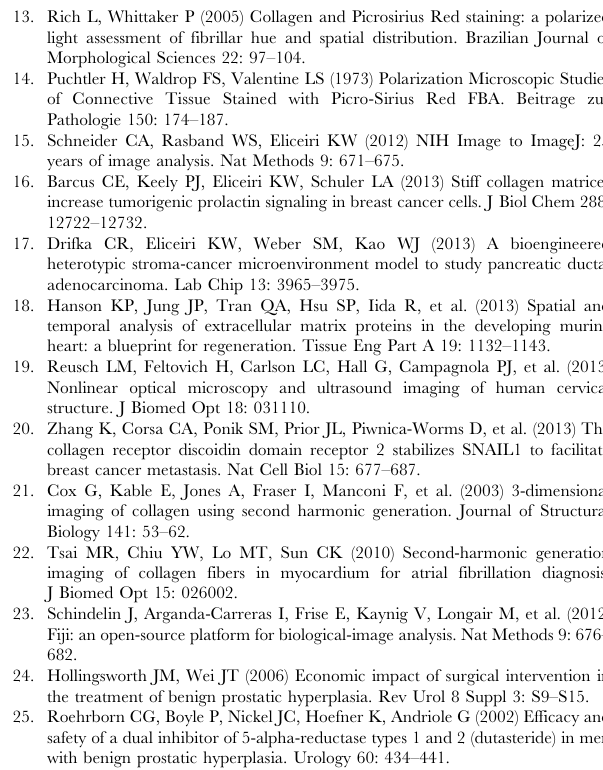
Figure S2 Separation and quantification of birefrin- gence in Picrosirius red stained prostate tissues. Prostate tissues were stained with Picrosirius red and imaged under brightfield ( A ) and circular polarized light ( B ) microscopy. Individual colors of birefringence were separated using threshold- ing of hue, saturation, and brightness values ( C ). ImageJ was used to quantify total birefringent area in the region of interest and the proportion of individual birefringent colors ( D ) comprising that